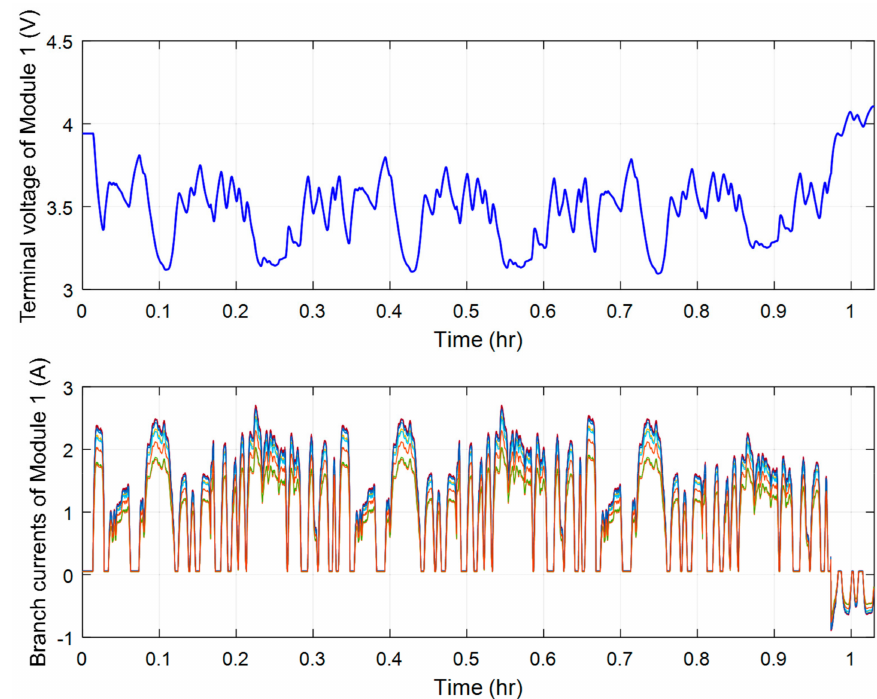
Figure 13. Voltage varying and currents through the cells in cell Module